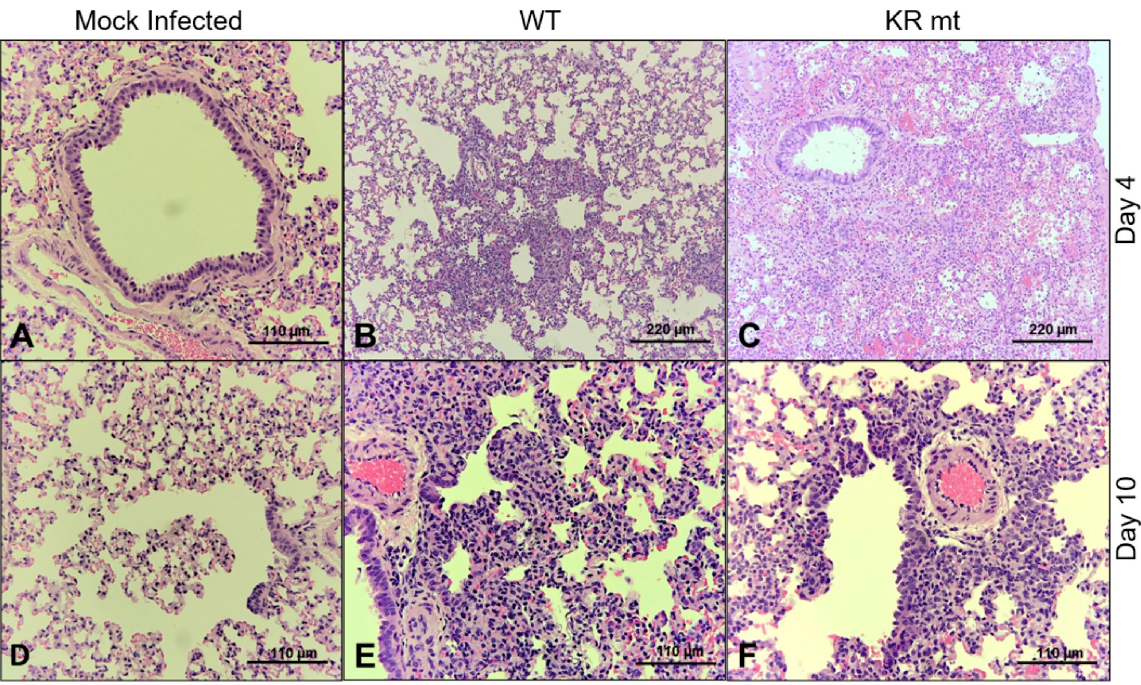
Fig 3. Lung histopathology in hamsters infected with WT and KR mt SARS-CoV-2. Lung tissue was harvested, fixed, and 5 μ m sections cut from mock, WT SARS-CoV-2, or KR mt-infected hamsters and stained with hematoxylin and eosin. ( A ) Normal bronchus, pulmonary artery, and alveoli in mock infection on day 4 (20X). ( B ) Bronchiolitis, peribronchiolitis, interstitial pneumonia, and edema surrounding branch of the pulmonary artery at day 4 in hamsters infected with WT virus (10X). ( C ) Severe bronchiolar cytopathic effect, interstitial pneumonia, cytopathic alveolar pneumocytes, alveoli containing mononuclear cells and red blood cells at day 4 in hamsters infected with KR mt. This lesion extended over numerous fields (10X). ( D ) Normal respiratory bronchiole, alveolar ducts, and alveolar sacs in mock infection on day 10 (20X). ( E ) Interstitial pneumonia adjacent to a bronchus at day 10 in hamsters infected with WT (20X). ( F ) Bronchiolar epithelial cytopathic effect, peribronchiolitis, focal interstitial pneumonia, branch of pulmonary artery with surrounding edema and mononuclear cell infiltration of endothelium at day 10 in a hamster infected with the KR mt (20X). Shown are representative images typical of data gathered from 5 animals from each